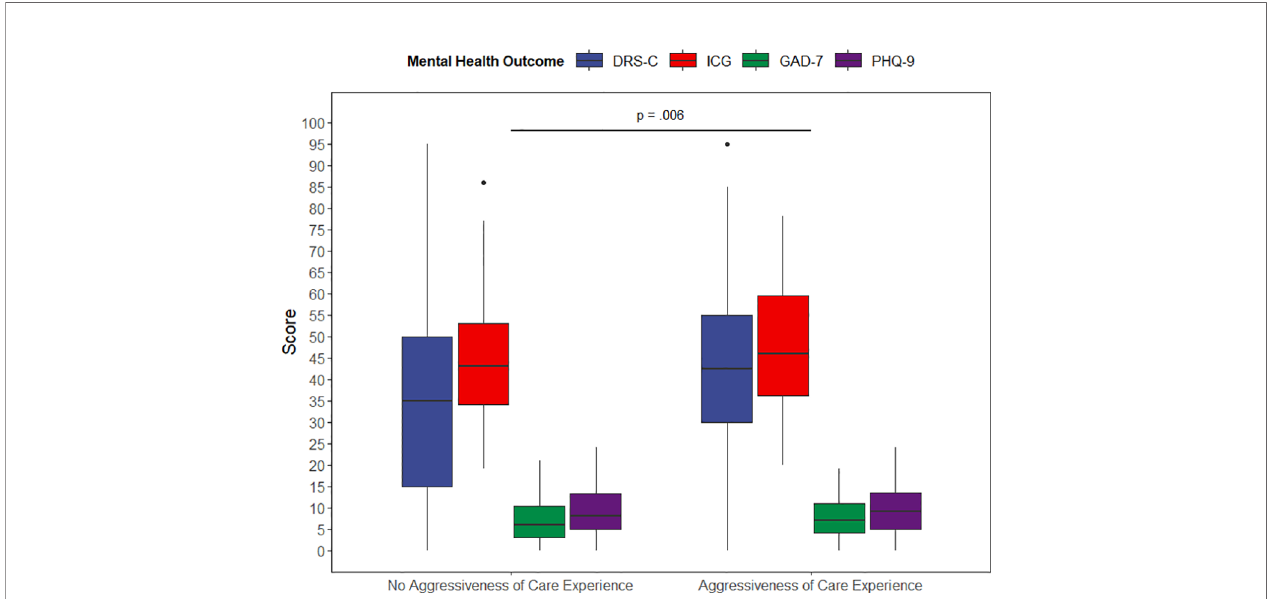
FIGURE 3 | Results of the Multivariate Analysis of Variances (MANOVA). Note: MANOVA, F (4 ,253) = 3.75, p = 0.006, partial eta-squared = 0.06, n = 278 ; Games – Howell method for pairwise comparisons. Adjusted p-value using Tukey ’ s method. DRS-C, Decision Regret Scale for Caregivers; ICG, Inventory of Complicated Grief; GAD-7, Generalized Anxiety Disorder Scale -7; PHQ-9, Patient Health